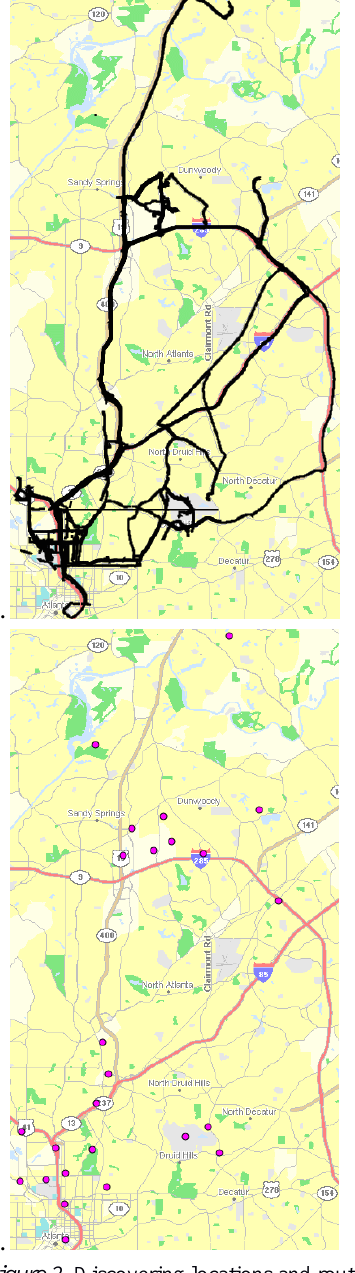
Figure 2. Discovering locations and routines of commuter movement. (a) an unfiltered time series of GPS data, (b) places where the user stops for more than 10 min, (c) clustering places into locations, and (d) creating a Markov model based on the user’s past transitions between